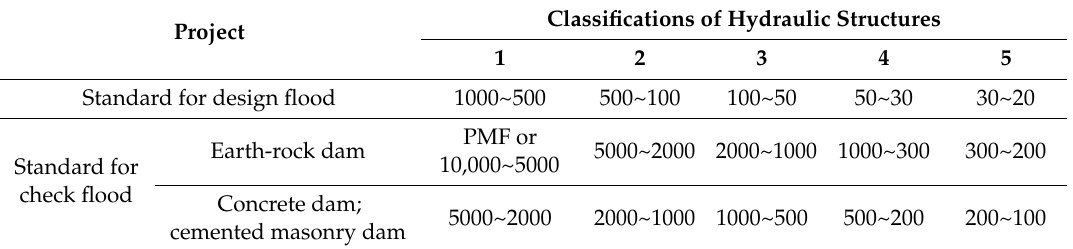
Table 3. Flood control standard for permanent hydraulic structures in mountainous and hilly areas, return period